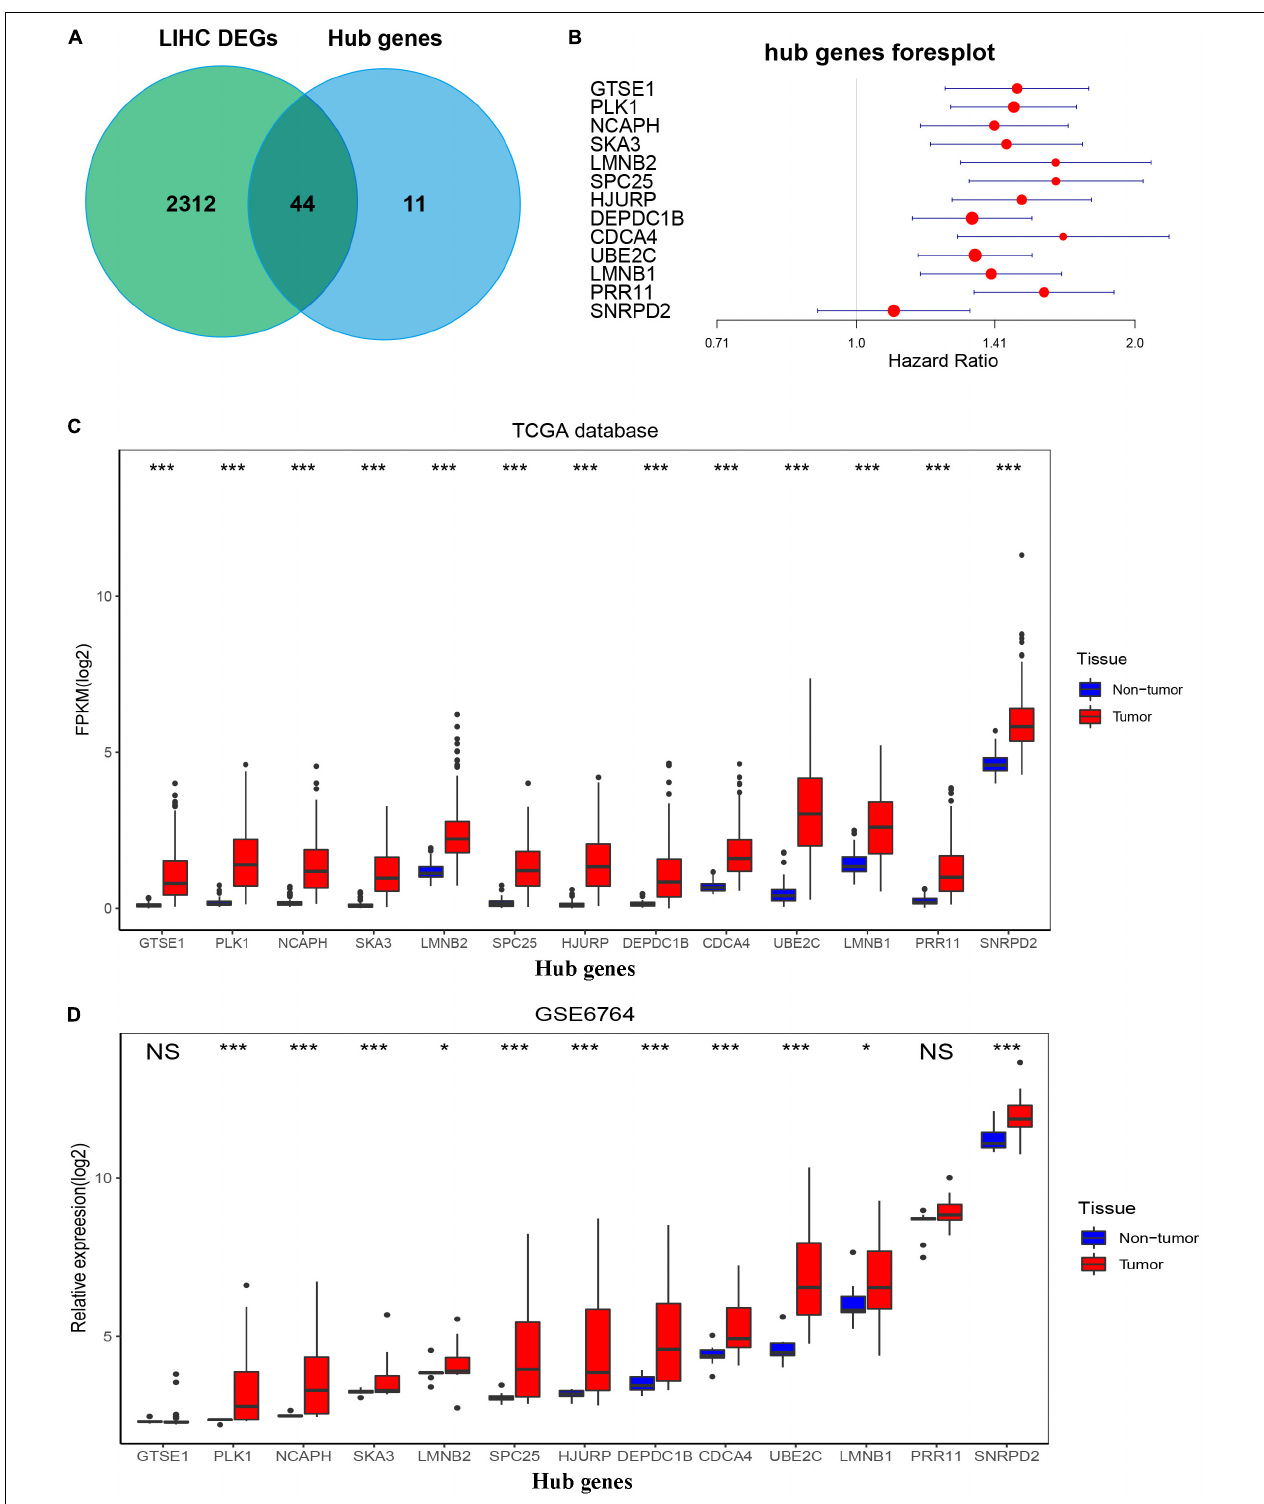
FIGURE 7 | Confirmation and validation of 13 hub genes differentially expressed in tumor tissues and non-tumor tissues in the TCGA database and GSE6764. (A) The 44 common genes between all DEGs according to the edgeR package and hub genes according to WGCNA. (B) Forest plot of 13 hub genes. (C) The boxplot of 13 hub genes differentially expressed in tumor and non-tumor tissues of HCC in the TCGA database. P -value was calculated by t -test. * p < 0.05, *** p < 0.001. (D) Boxplot of 13 hub genes differentially expressed in tumor and non-tumor tissues of HCC in GSE6764. P -value was calculated by t -test. * p < 0.05, *** p < 0.001; NS, no